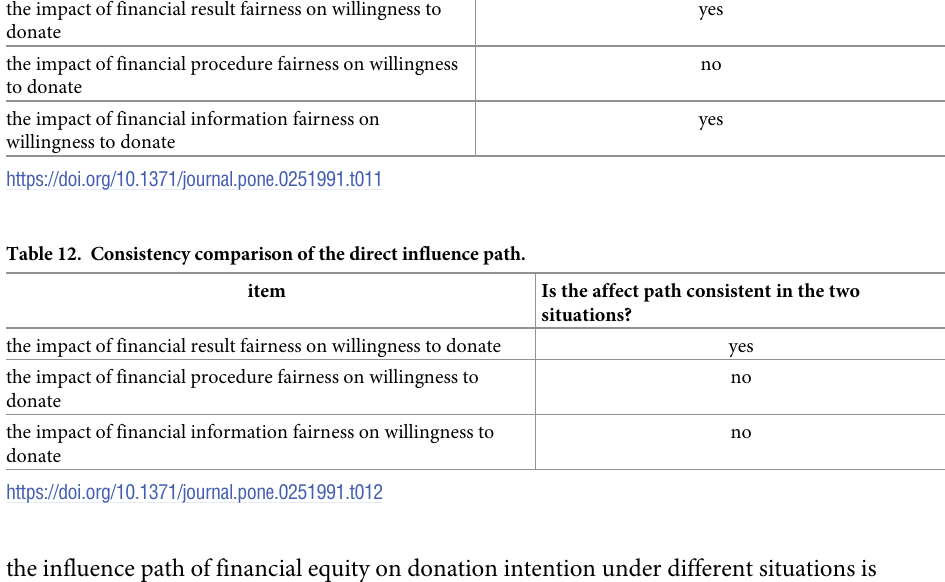
situations? yes no yes